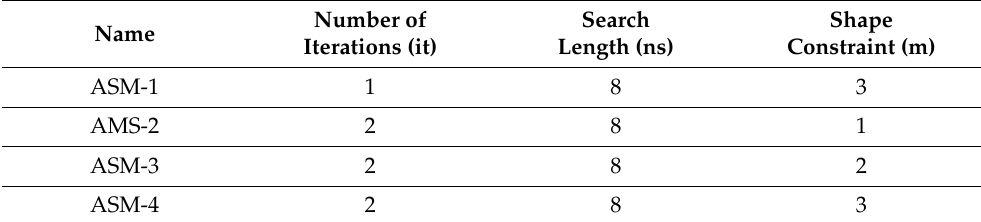
Number of Iterations (it)